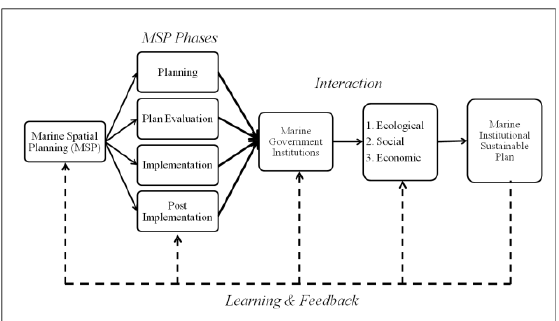
Figure 7. A Framework of Marine Government Institutional